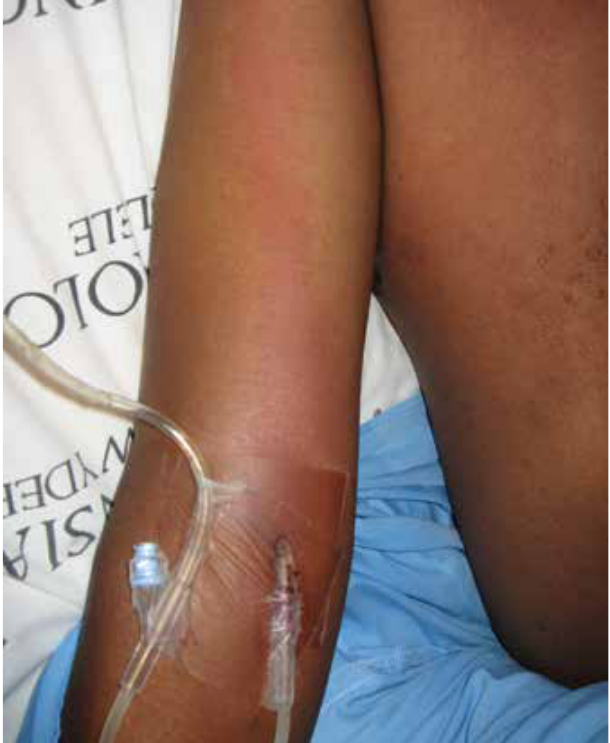
Fig. 2. ‘Chemical’ phlebitis complicating amphotericin B infusion (photograph courtesy of Dr T A Bicanic). This inflammation occurred during the 4-hour amphotericin B infusion and presented as redness and tenderness tracking up the cannulated vein. In such cases, the cannula should be removed once the infusion is completed and the site monitored closely for infection and the patient for fever. This is not an indication for immediate